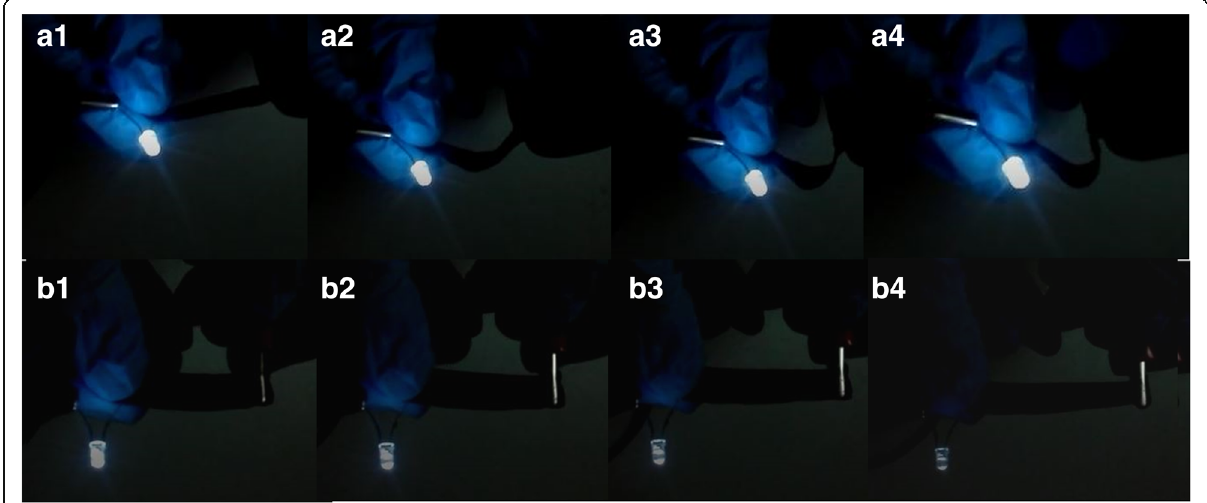
Fig. 10 Flexible conductor of the PANI/TPU membrane in closed circuit. a Self-flashing LED could give out light normally when the flexible con- ductor of PANI/TPU membrane was under different curvatures. b Self-flashing LED dimming with tensile strain of PANI/TPU membrane